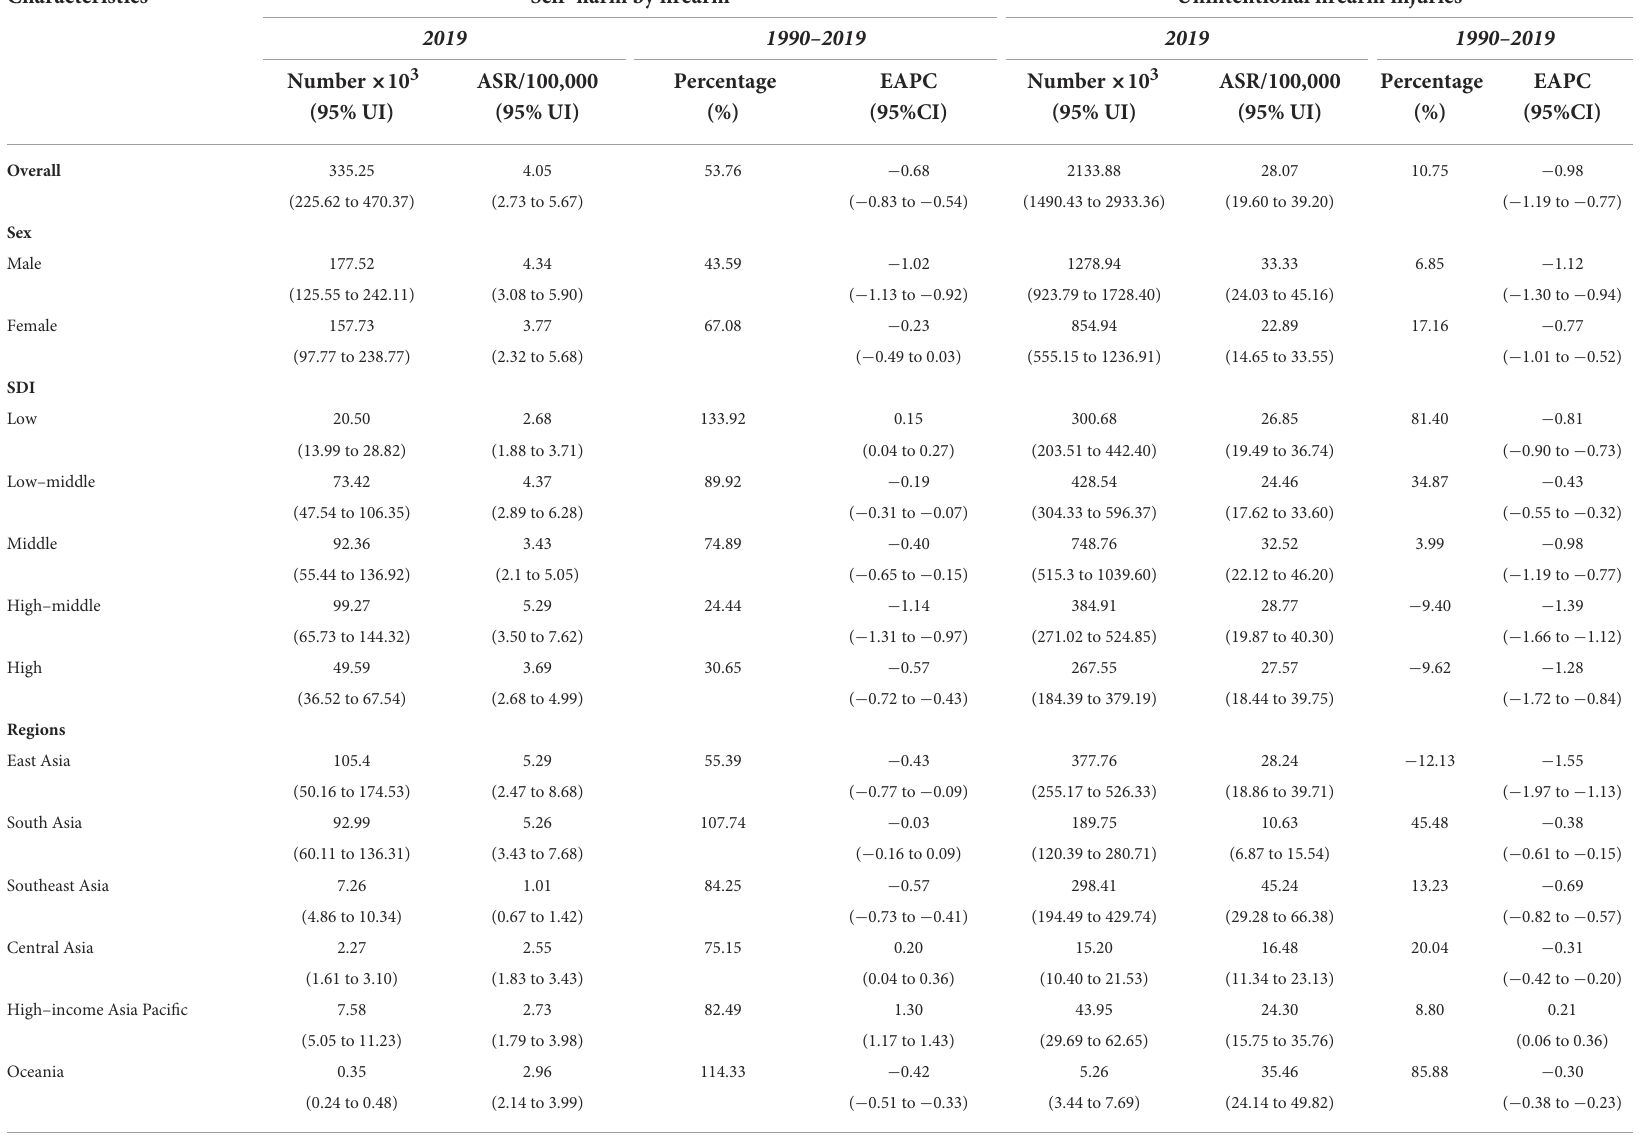
TABLE 2 Global incident burden and trends in self–harm by firearm and unintentional firearm injuries in sexes, SDI areas, and regions